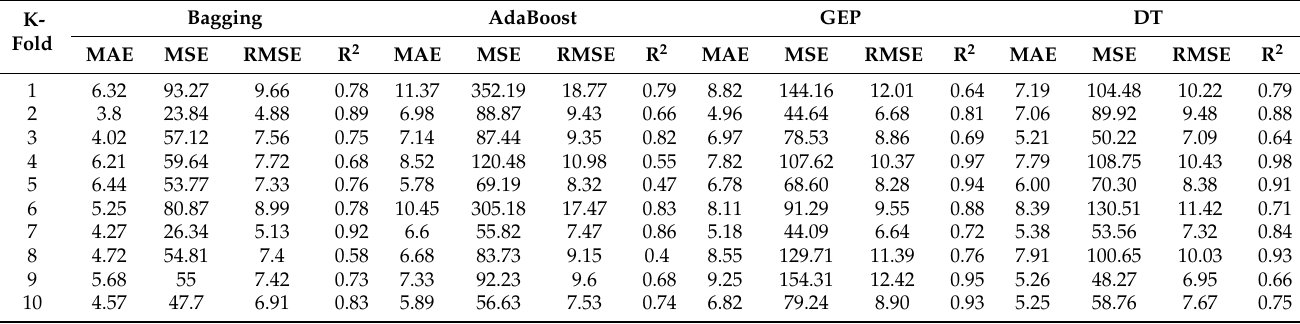
Table 3. Results of k-fold